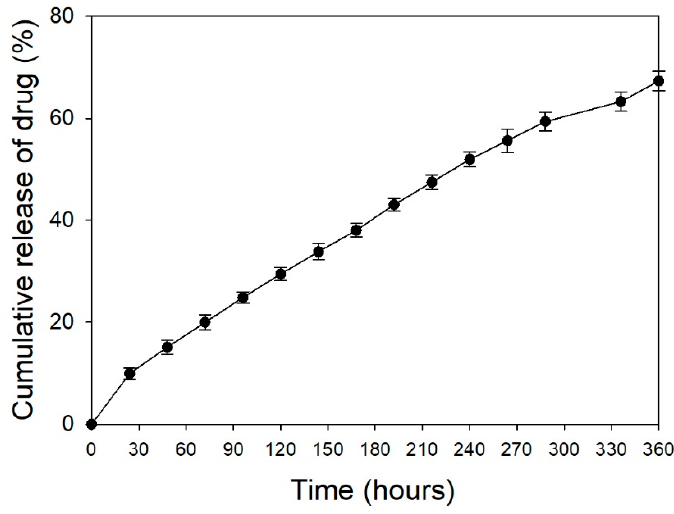
Figure 6. In vitro cumulative tetracycline (TC) release from TC-loaded p-HApFs.